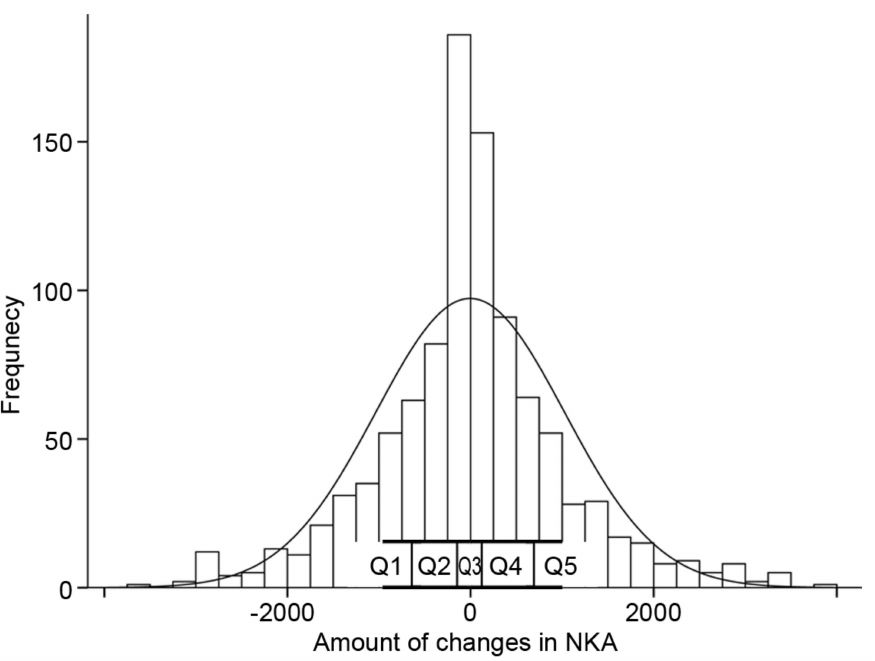
Figure 4. The distribution of the natural killer cell activity changes. Q1–5 represents quintiles of change amount in natural killer cell activity. NKA, natural killer cell activity.